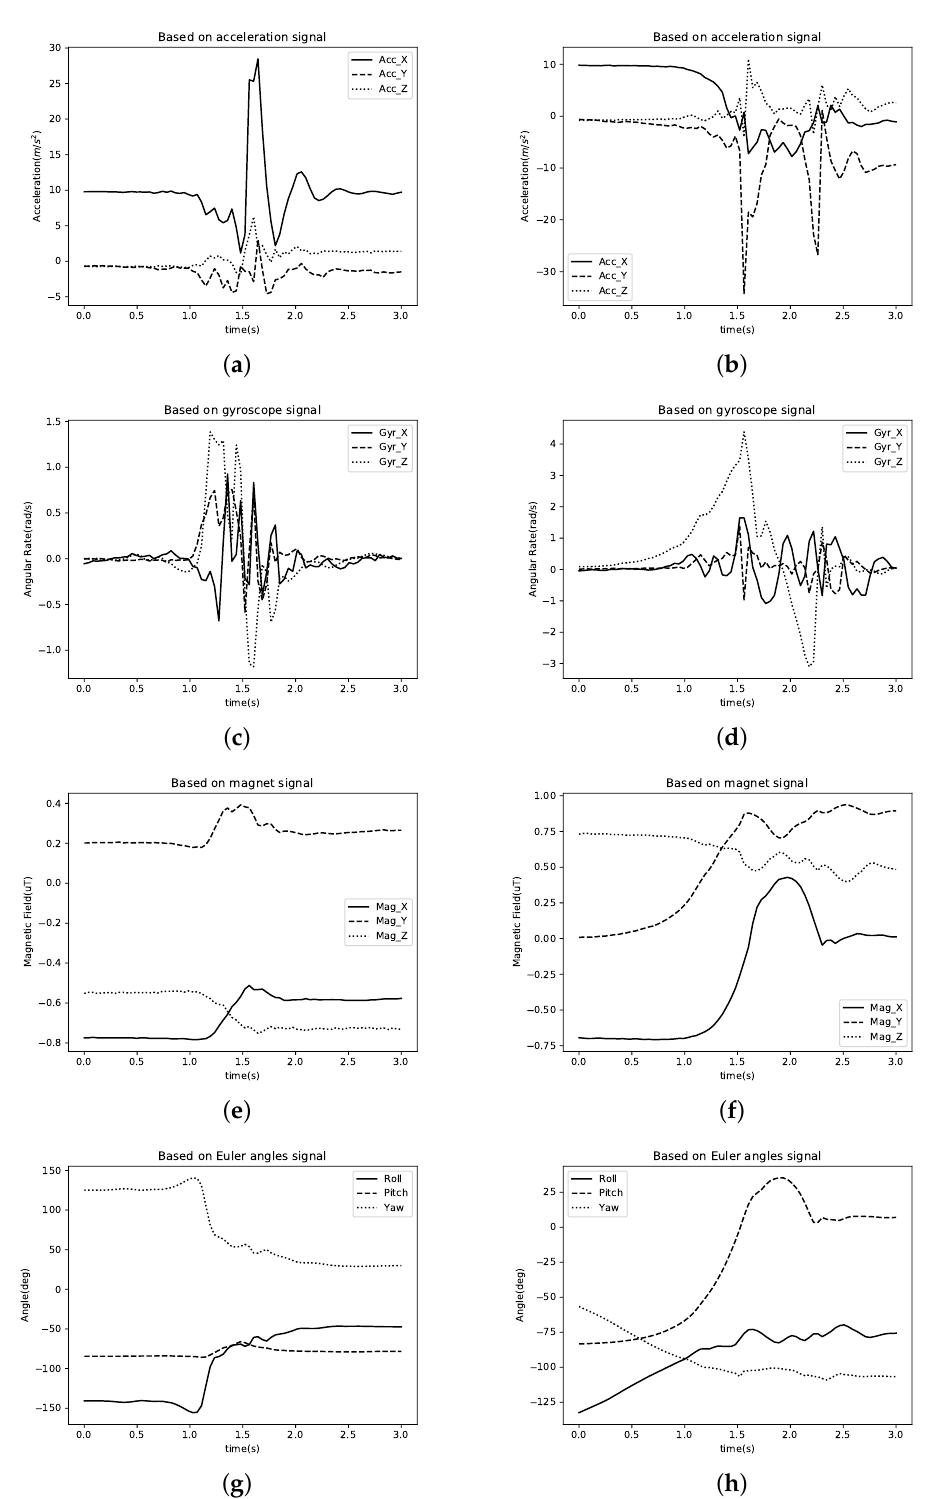
Figure 3. Examples of sensor signals for a front-knees action and a back-lying action: ( a ) front- knees, acceleration; ( b ) back-lying, acceleration; ( c ) front-knees, gyroscope; ( d ) back-lying, gyroscope; ( e ) front-knees, magnet; ( f ) back-lying, magnet; ( g ) front-knees, Euler angle; and ( h ) back-lying, Euler